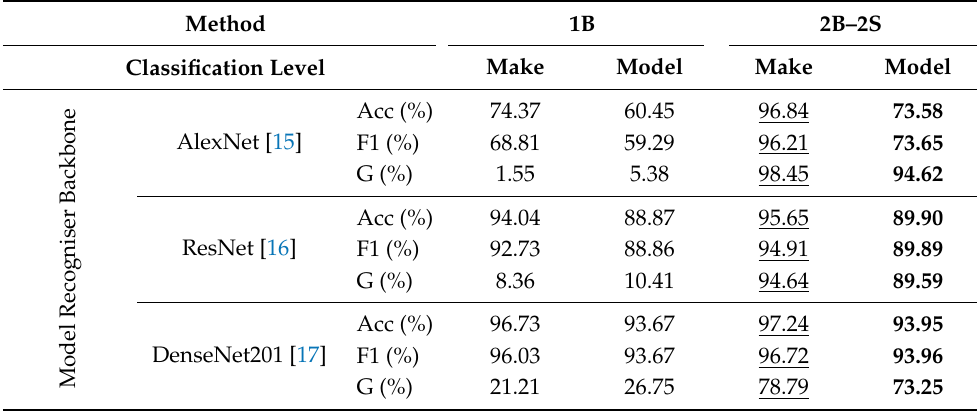
Table 8. VMMR results over DVMM-51.